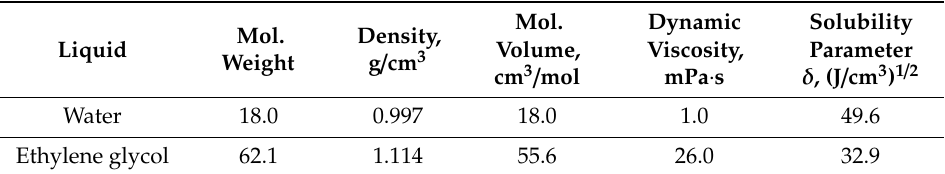
Table 2. Physicochemical properties of